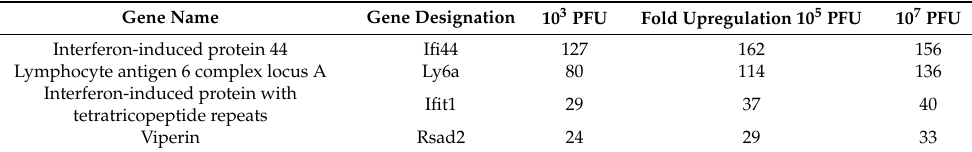
Table 1. Dose-dependent upregulation of the selected interferon (IFN)-induced and associated genes in mouse CSCs infected with WNV. CSCs were treated with 10 3 , 10 5 , or 10 7 PFU of WNV.